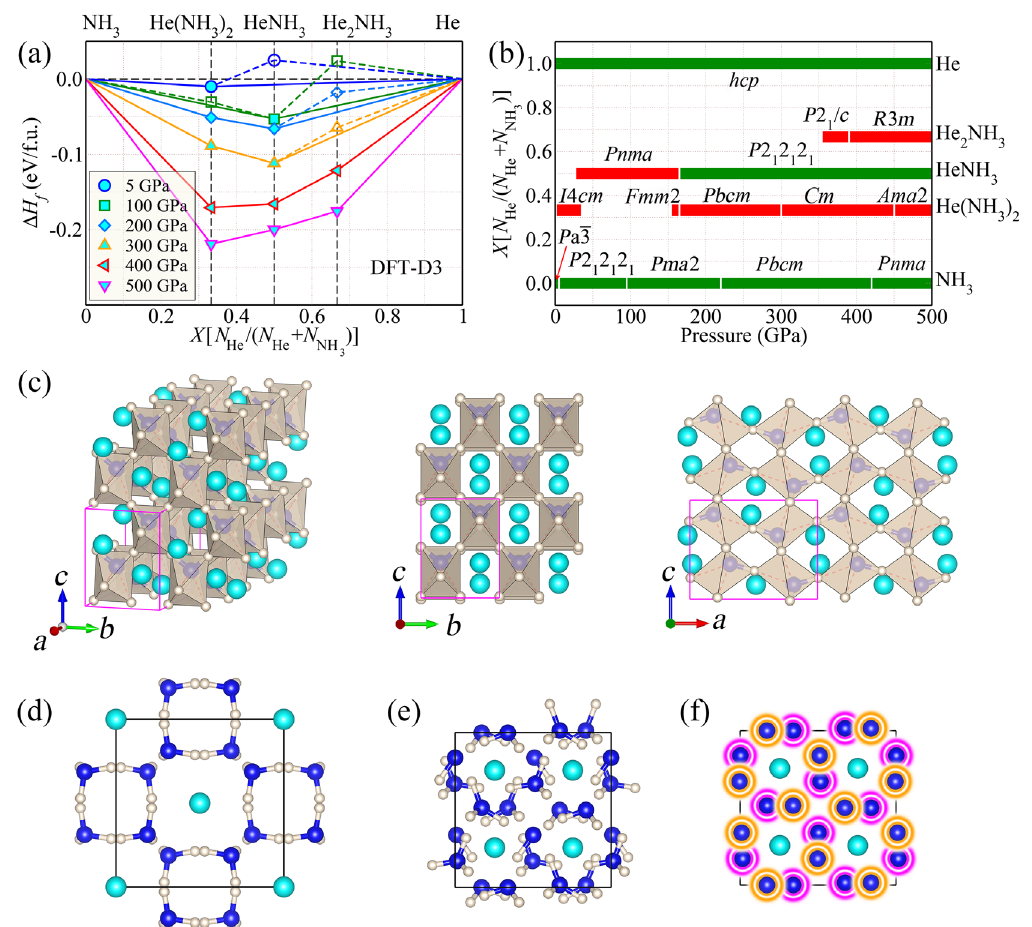
FIG. 1. Energetics of the He-NH 3 system and crystal structures of the most interesting stable compounds. (a) Convex hulls for formation enthalpies ( Δ H f , with respect to pure He and NH 3 ) at different pressures, calculated with the PBE þ DFT-D 3 functional [49]. (b) Pressure-composition phase diagram of the He-NH 3 phases discovered in this work (red bars), together with the previously known phases (green bars) up to 500 GPa. (c) Typical perovskite HeNH 3 crystal structure of the Pnma phase at 100 GPa. (d) – (f) Typical crystal structures of host-guest phases in He ð NH 3 Þ 2 . (d) the I 4 cm phase at 3 GPa and (e) the Ama 2 phase at 500 GPa. (f) Representation of the host-guest structure of the He ð NH 3 Þ 2 structures. Nitrogen atoms are arranged in two layers highlighted by yellow and magenta. Blue, gray, and cyan balls represent N, H, and He atoms,